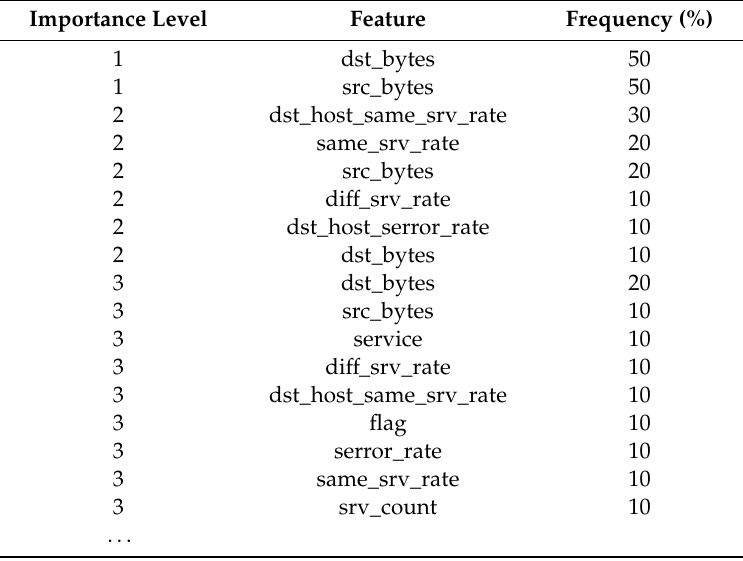
Table 2. The most frequent feature combinations by importance order—NSL-KDD dataset, 10 runs. For each importance level, the features that were placed to that level are listed with the percentages of their occurrence at that level among runs for the built-in method.